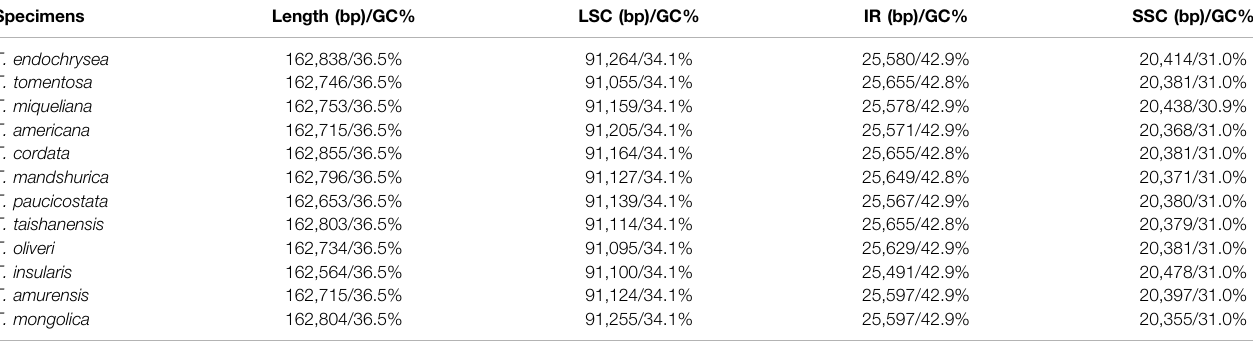
TABLE 1 | Characteristics of complete chloroplast genomes of Tilia species. Specimens